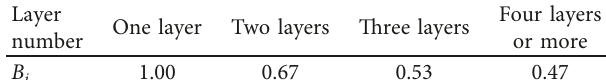
i of the number of strata.